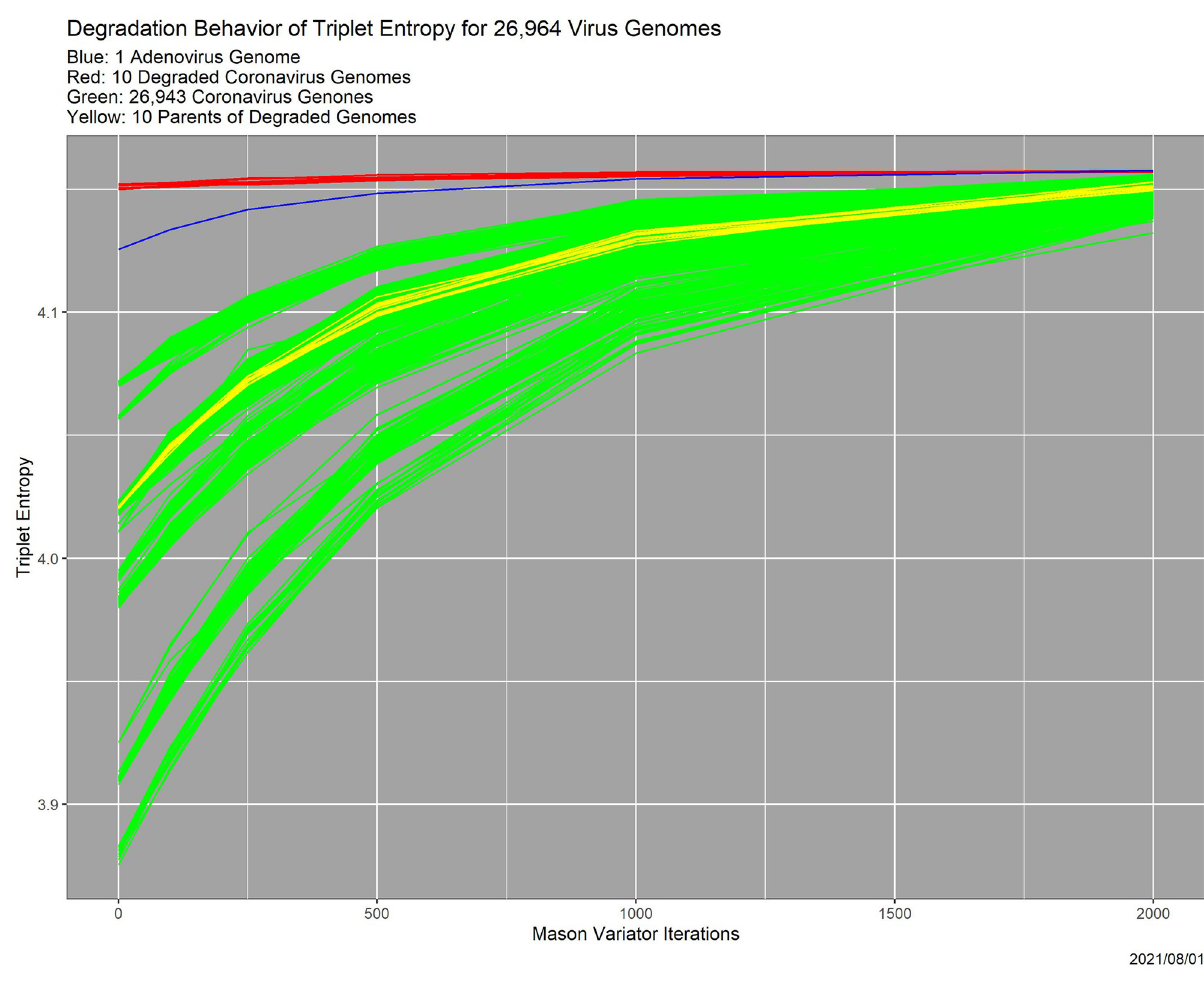
Fig 5. Entropy as a function of Mason_variator iterations, for the 26,964-genome dataset. The adenovirus outlier is in blue, the 10 degraded coronavirus outliers are in red, and the parents of the ten coronavirus outliers are in